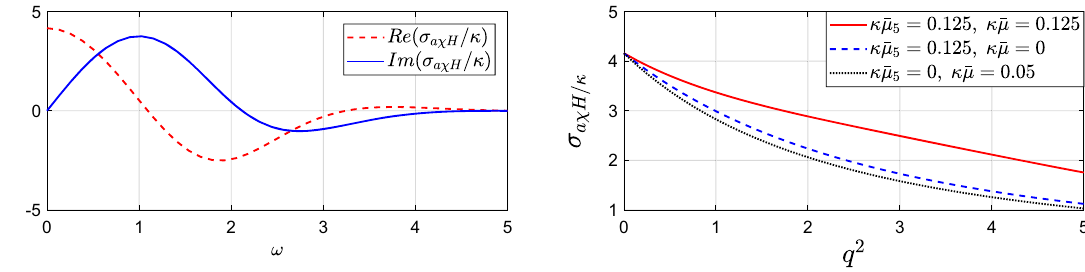
Fig. 9 ω -dependence of σ a χ H /κ when q = 0 (left); q 2 -dependence of σ a χ H when ω = 0 (right)